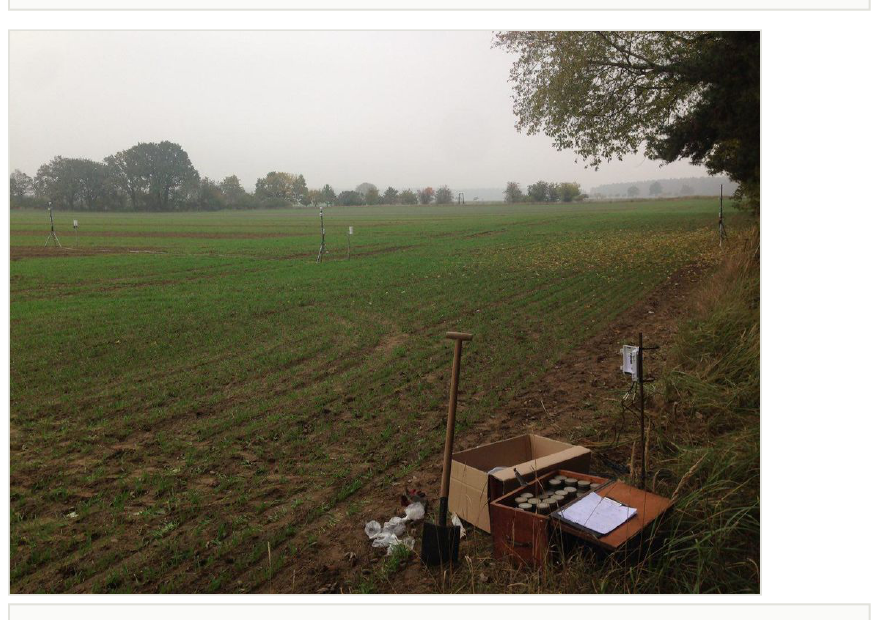
Figure 3. Examplary picture of the forest edge at the west-facing site. View towards north.